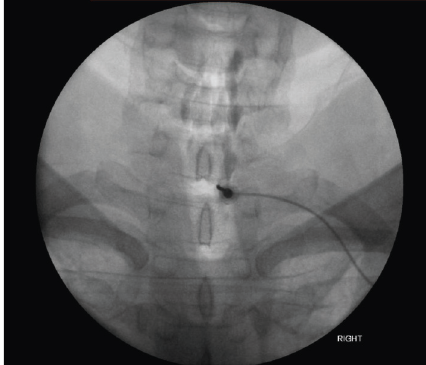
Figure 4: Posterior-approach cervical epidural blood patch under fluoroscopy.